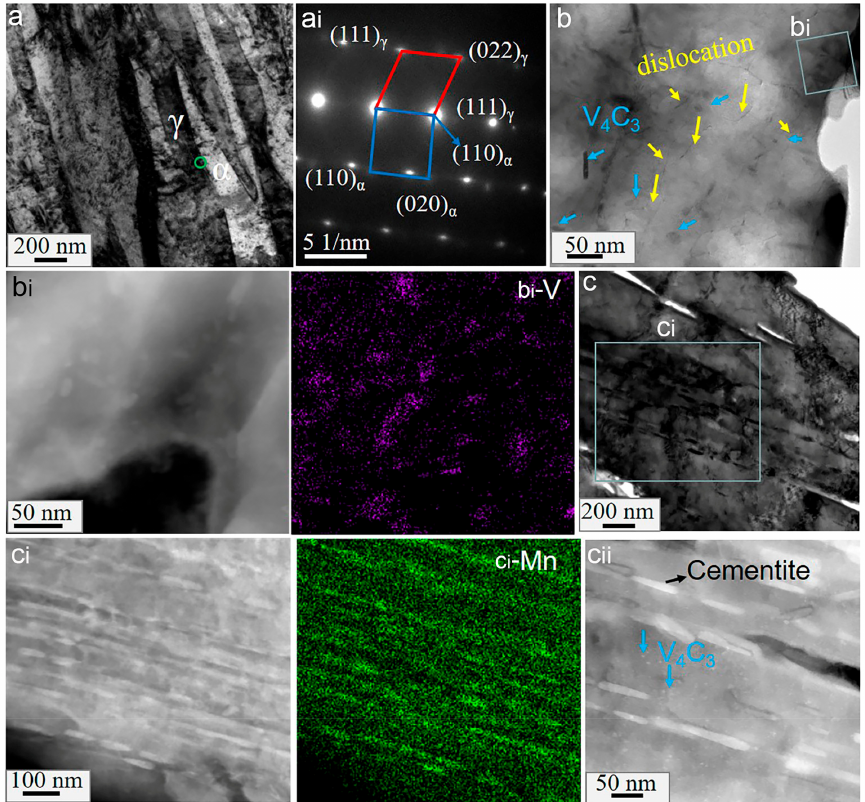
Figure 8. TEM micrographs of sample LV600: ( a ) the bright field images; ( b , c ) the distribution of carbides, where ( a i ), ( b i ) and ( c i ) are the corresponding SADP in ( a ); EDXS surface analysis for ( b ) and ( c ), respectively, where ( c ii ) is a magnification of ( c i ); b i -Mn and c i -V refer to the distribution of V and Mn elements after surface analysis of b i and c i , respectively. The black arrow refers to